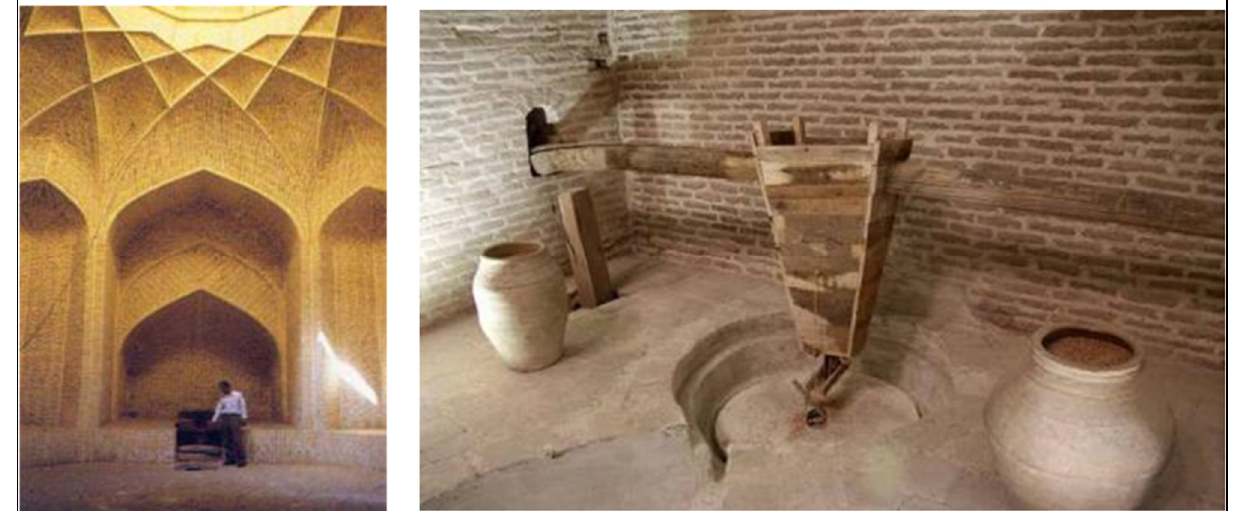
Figure 10. Ashkezar historical water mill in Yazd, Iran. Date of construction: 12 AD.